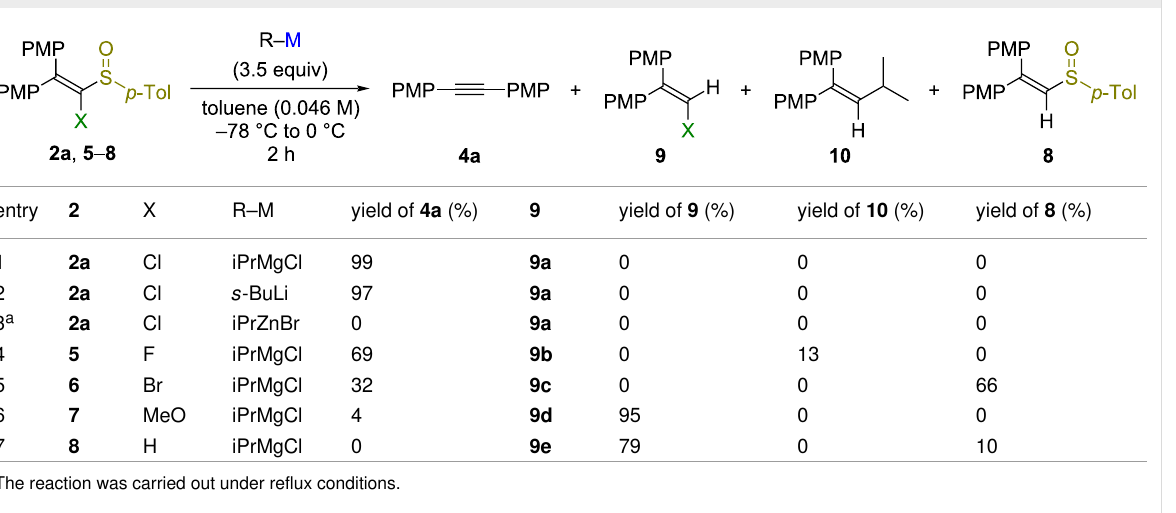
Table 1: Reaction of sulfoxides 2a and 5 – 8 with organometallic reagents.